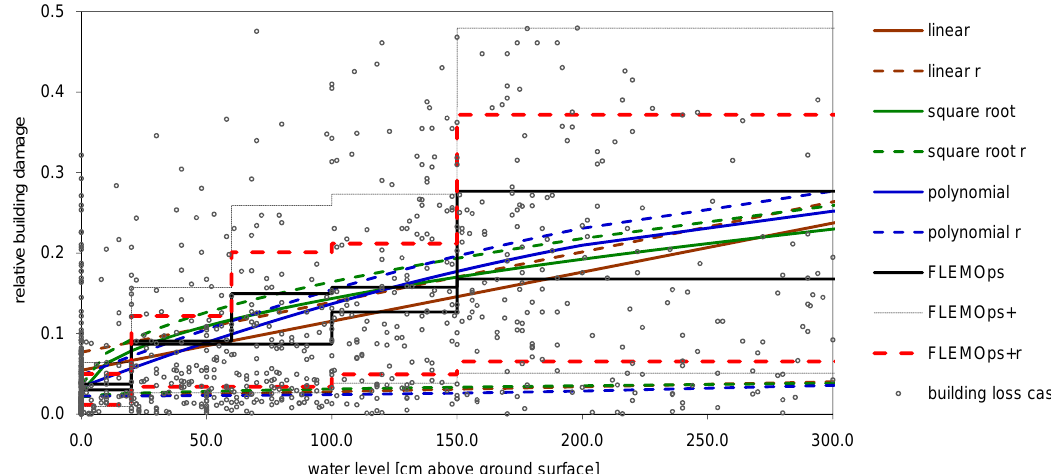
Fig. 5. Stage-damage-curves for loss model